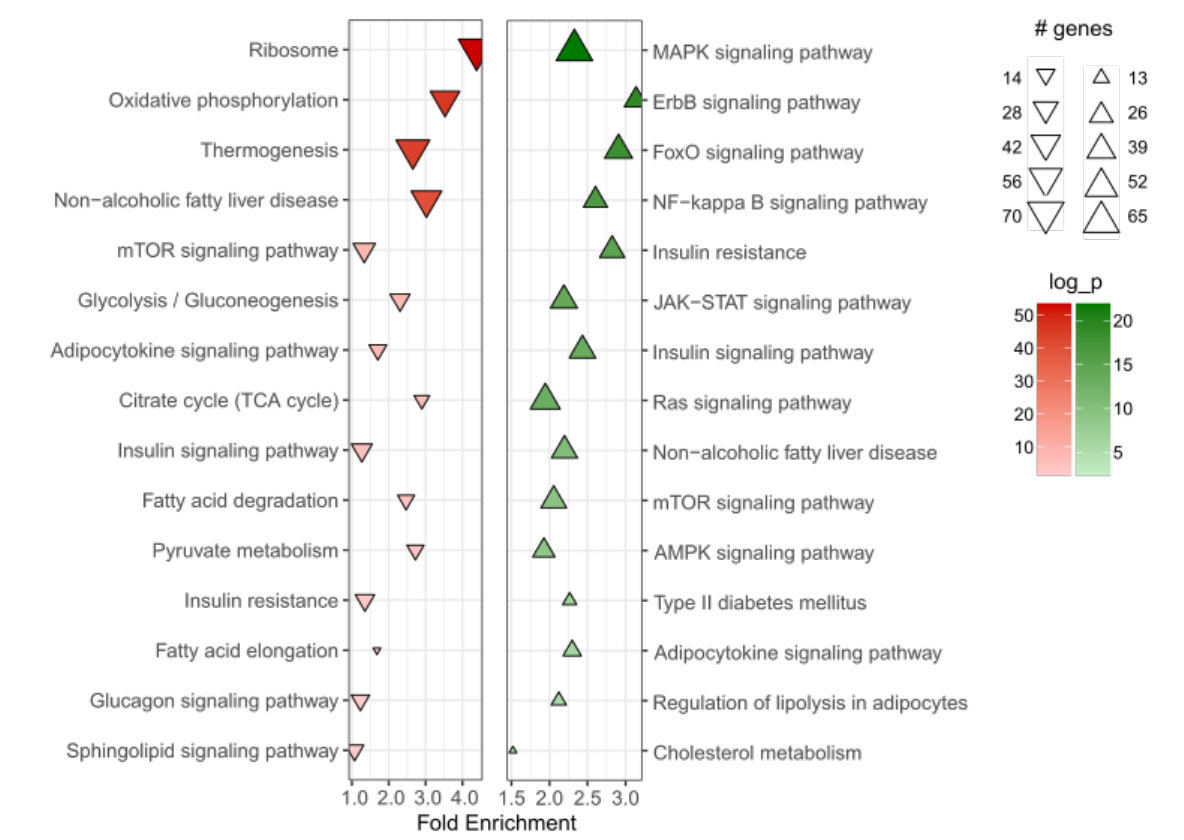
Figure 1. HMGCR expression in adipose tissue is associated with the indicated enriched terms identified based on KEGG database. The graph shows a list of positively (green) and negatively (red) associated terms. The complete list of all the enriched terms is provided in Supplementary Figures S1 and S2.